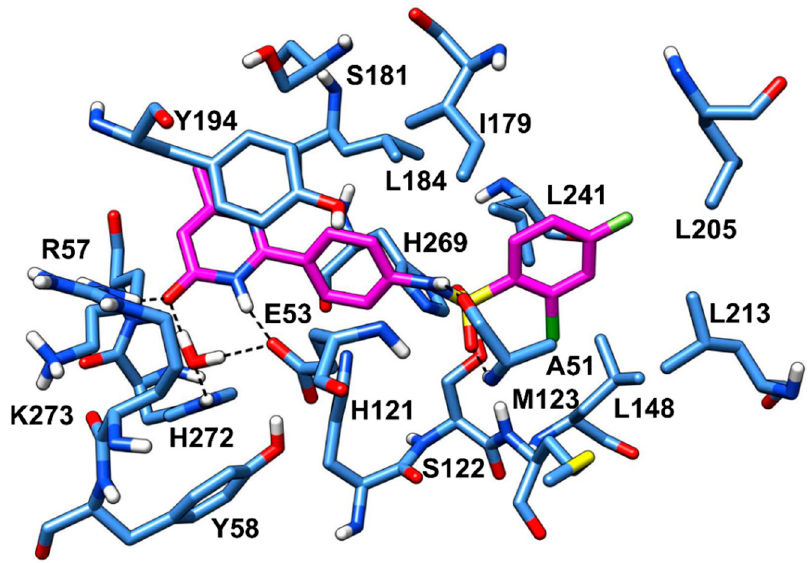
Figure 3. Minimized average structure of VS1 within MAGL binding site.